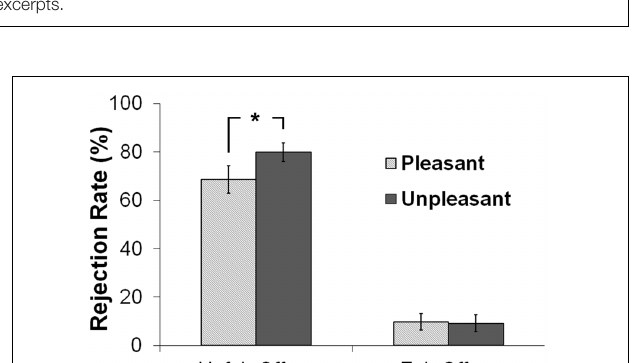
FIGURE 2 | (A) Positive and (B) negative affect changes after listening to musical excerpts.